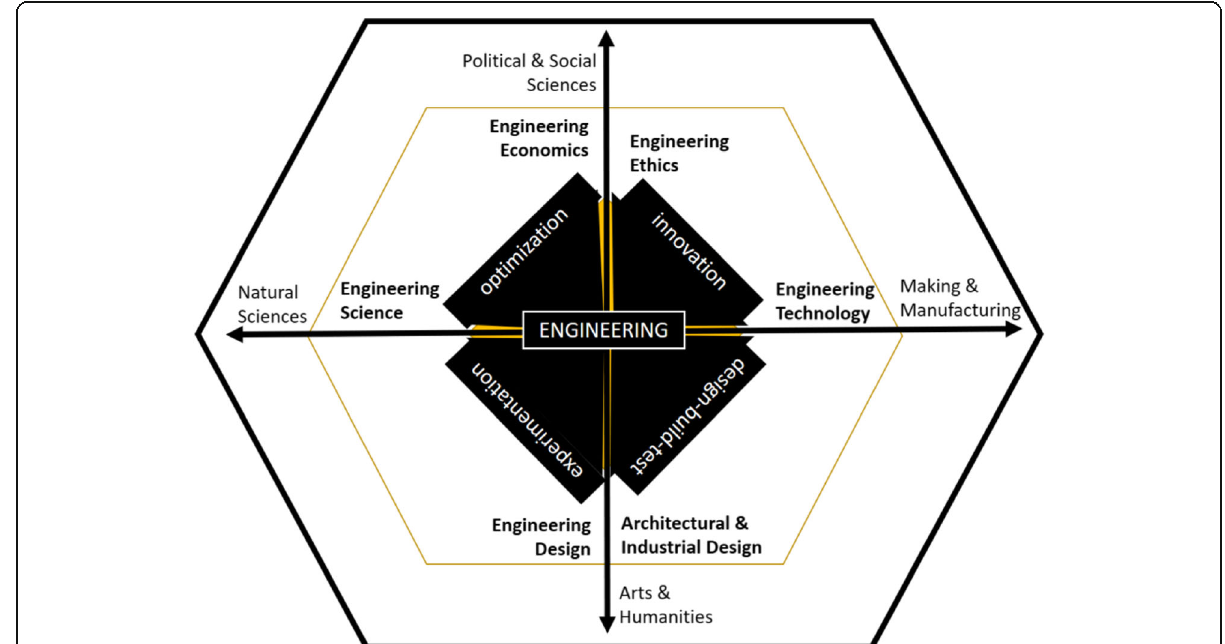
Fig. 1 Technical and social dimensions of engineering (adopted from Dixon,